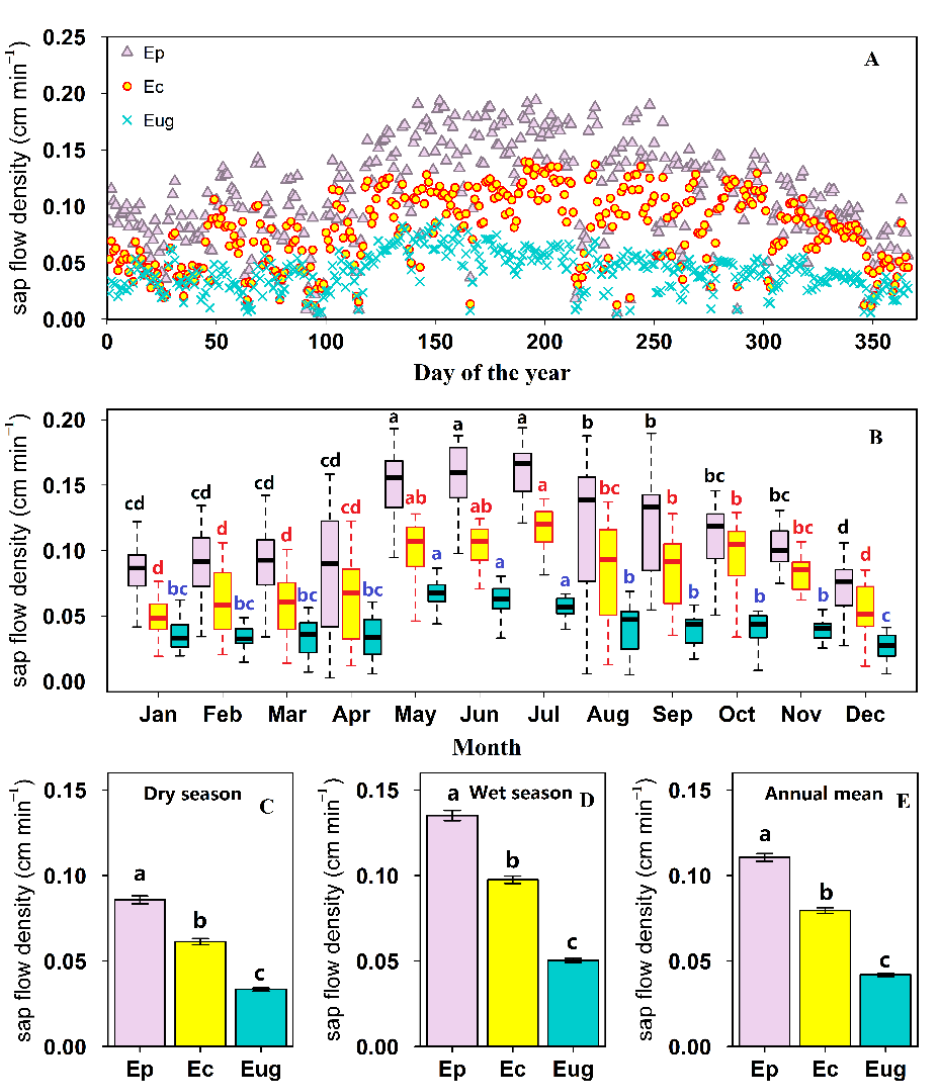
Figure 4. Panels ( A , B ) show the ( A ) variation of J C and the ( B ) monthly mean for J C in three eucalyptus species’ plantations during the monitoring period. Panels ( C − E ) indicate the mean J C of each species during the ( C ) dry season, ( D ) wet season, and ( E ) throughout the year. Error bars indicate the standard error. Different lowercase letters indicate significant differences ( p < 0.05). Ep, Ec, and Eug represent the eucalyptus species of E. pellita, E. camaldulensis, and E. urophylla × E. grandis , respectively. The T and monthly cumulative T for the three eucalyptus species’ plantations all followed the same seasonal pattern of gradual increases from January to May, with large values in May, June, and July, before decreasing again from August to December (Table 2). The total transpiration during the wet season (from May to October) was 456.52 mm for Ep, 192.00 mm for Ec, and 298.20 mm for Eug, which collectively accounted for approximately 60% of their total annual transpiration and 37.5%, 15.8%, and 24.5% of simultaneous precipitation, respectively. However, the total T of each species during the dry season accounted for 117.7% (Ep), 49.1% (Ec), and 80.1% (Eug) of the simultaneous